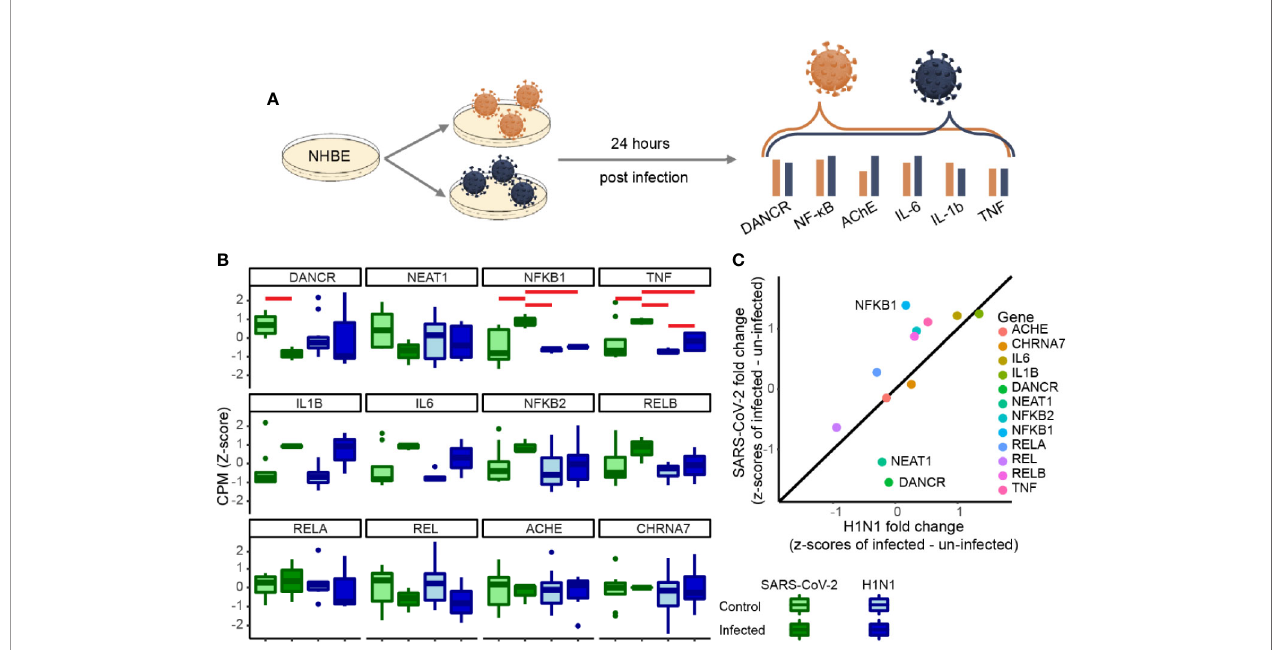
FIGURE 2 | DANCR, NEAT1 and NFkB1 reactions differentiate between SARS-CoV-2 and pandemic H1N1 infection. (A) Normalized expression (CPM, z-score) of genes of interest in SARS-CoV-2\pandemic H1N1 [both 24 h post-infection (p. i.)] and control lung bronchial epithelial cells. (B) Boxplots show normalized expression of biological replicates (n = 3 for SARS-CoV-2 infected and control and for H1N1-infected and n=6 for H1N1 control). Red horizontal lines mark signi fi cantly different expression (p < 0.05 ANOVA, FDR). (C) Z-score fold changes of infected minus control SARS-CoV-2\H1N1. Black line shows y=x slope. NFkB1, DANCR, and NEAT1 show signi fi cant changes (p < 0.01), all other genes are found within the 0.99 SD of the